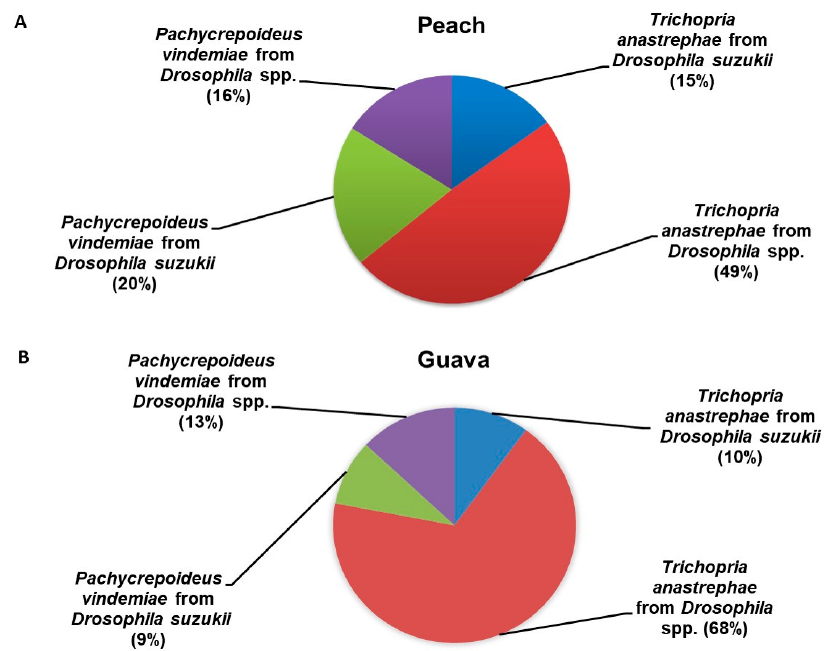
Figure 5. Relative abundance of Pachycrepoideus vindemiae and Trichopria anastrephae adults recovered from Drosophila suzukii and saprophytic Drosophila spp. Puparia, associated with ( A ) peach and ( B ) guava. Trichopria anastrephae was remarkably successful in parasitizing saprophytic Drosoph- ila spp. puparia located inside peach and guava flesh, followed, in decreasing order, by puparia found “outside fruit flesh” and in the “soil” (Figure 6A,B). The above pattern was also recorded in SWD puparia (Figure 6A,B). However, T. anastrephae was considerably more successful in parasitizing Drosophila spp. puparia than SWD puparia in both “inside fruit flesh” and “outside fruit flesh” microhabitats; this was not the case for puparia lo- cated in the soil, as there was no significant difference in parasitism between drosophilids (Figure 6A,B). Pachycrepoideus vindemiae significantly parasitized more saprophytic Dro- sophila spp. puparia outside fruit flesh when compared to the other tested microhabitats on peach and guava (Figure 6C,D). Nevertheless, the parasitism success of P. vindemiae on SWD puparia located in both “outside fruit flesh” and “soil” was statistically similar to that recorded from Drosophila spp. puparia outside fruit flesh when only peach was eval- uated (Figure 6C). In guava, significantly more SWD puparia were also parasitized by P. vindemiae in both “outside fruit flesh” and “soil” microhabitats, but the success of such parasitism was statistically lower than that recorded from Drosophila spp. puparia located outside the flesh (Figure 6D). Pachycrepoideus vindemiae parasitized a significantly higher number of Drosophila spp. puparia located “inside fruit flesh” than SWD puparia found in the same microhabitat in peach, although there were no statistical differences for guava (Figure 6C,D).